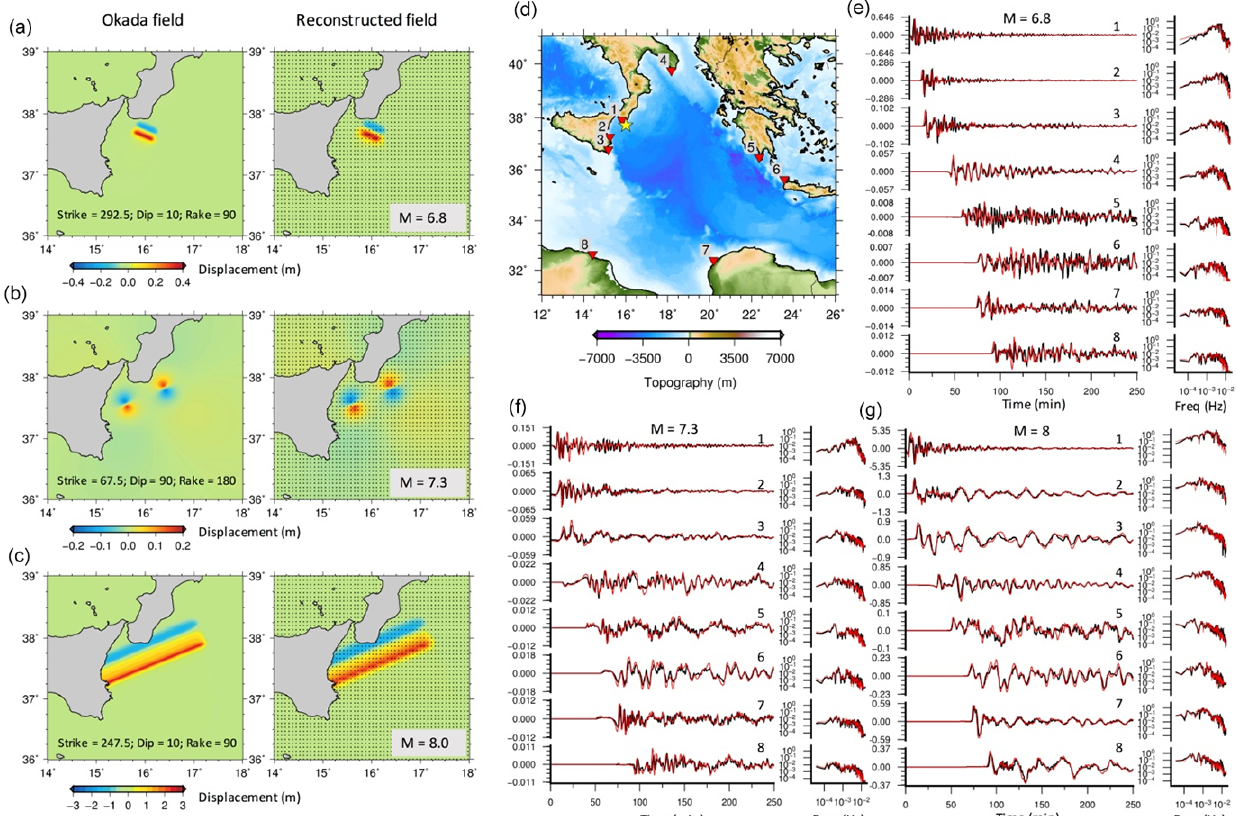
Figure 2. (a–c) Three examples of original initial conditions with different faulting parameters and earthquake magnitudes (left panels) and their reconstruction (right panels) obtained through the linear combination of the Gaussian-shaped sources. (d) Tsunami receivers (red triangles) and epicentres (yellow star) of scenarios in (a) – (c) . (e–g) Comparison between simulated (black lines, NS in the main text) and linearly combined (red lines, LC in the main text) waveforms and frequency spectra, corresponding to the scenarios in (a) – (c) . In panels (e) to (g) the vertical axes show the recorded wave heights expressed in